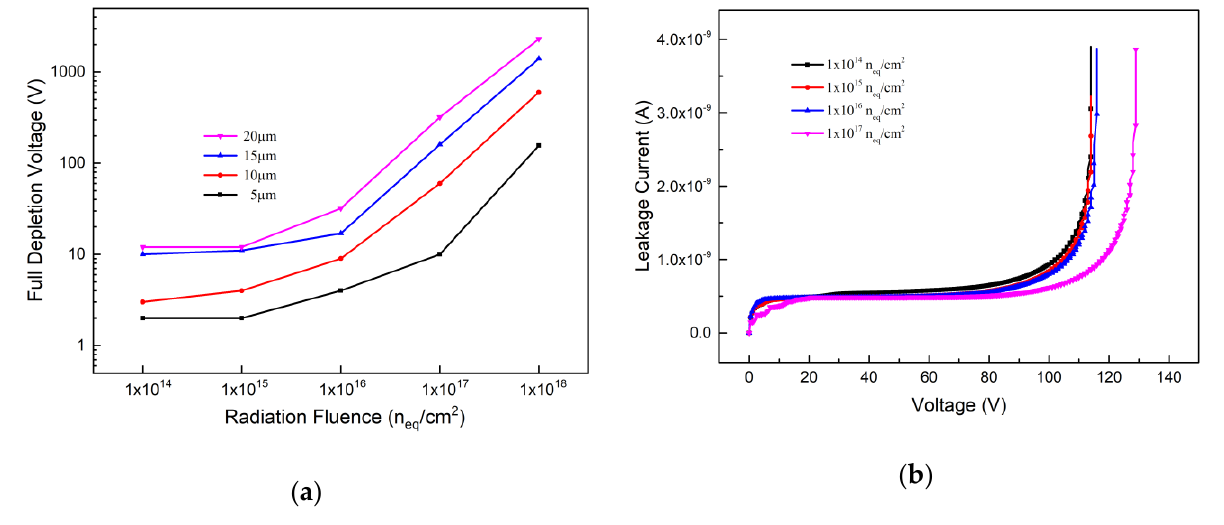
Figure 5. ( a ) The full depletion voltages; ( b ) Breakdown voltages.